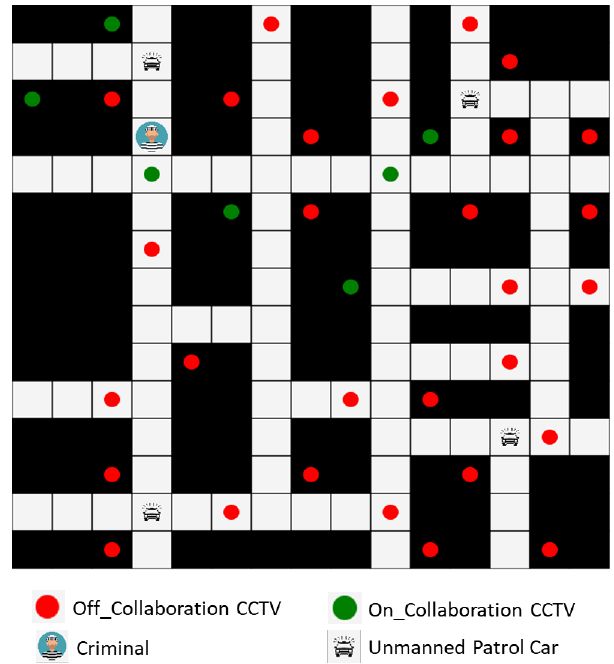
Figure 5. A Simulated application for the arrest of a criminal suspect by a collaboration of unmanned patrol cars and CCTVs.